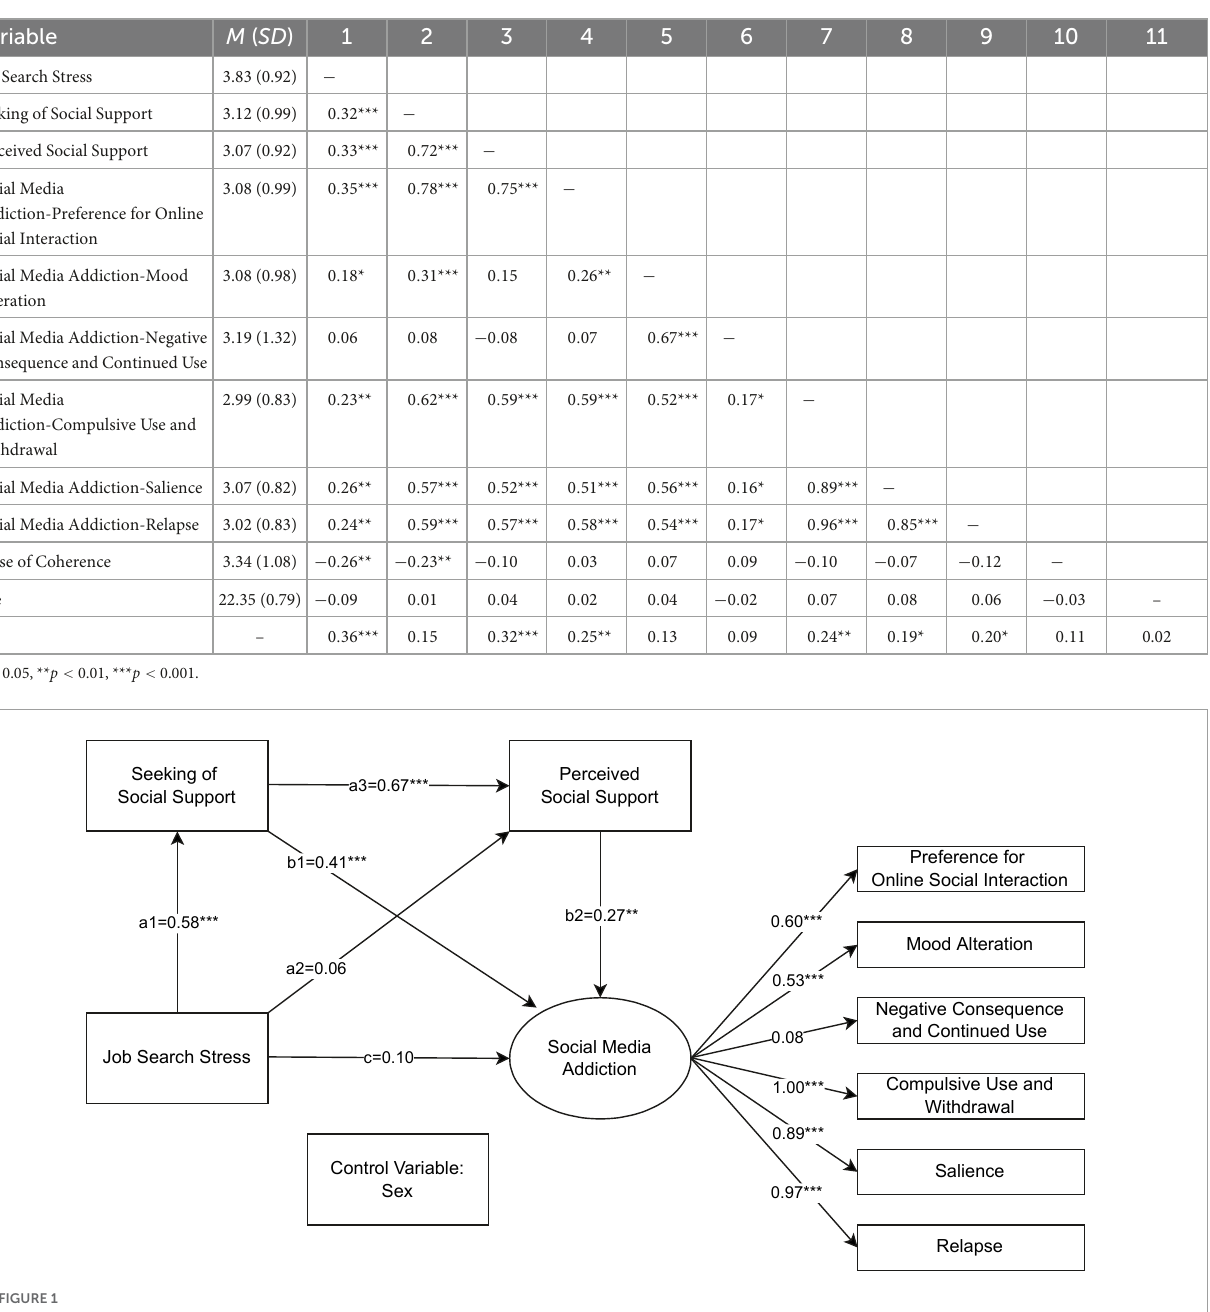
TABLE 1 Descriptive statistics and zero-order correlations of the variables analyzed in this study.